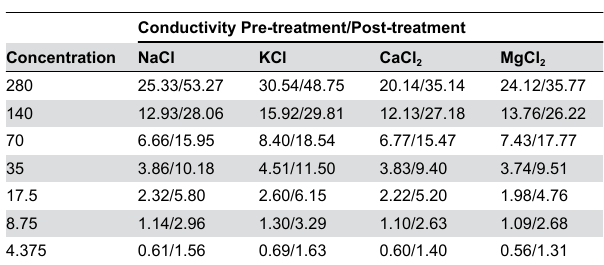
Table 1. - Conductivity (mS/cm) of NaCl, KCl, CaCl samples at the different concentration (4.375-280 mEq/l), before and after treatment with the ion-exchange